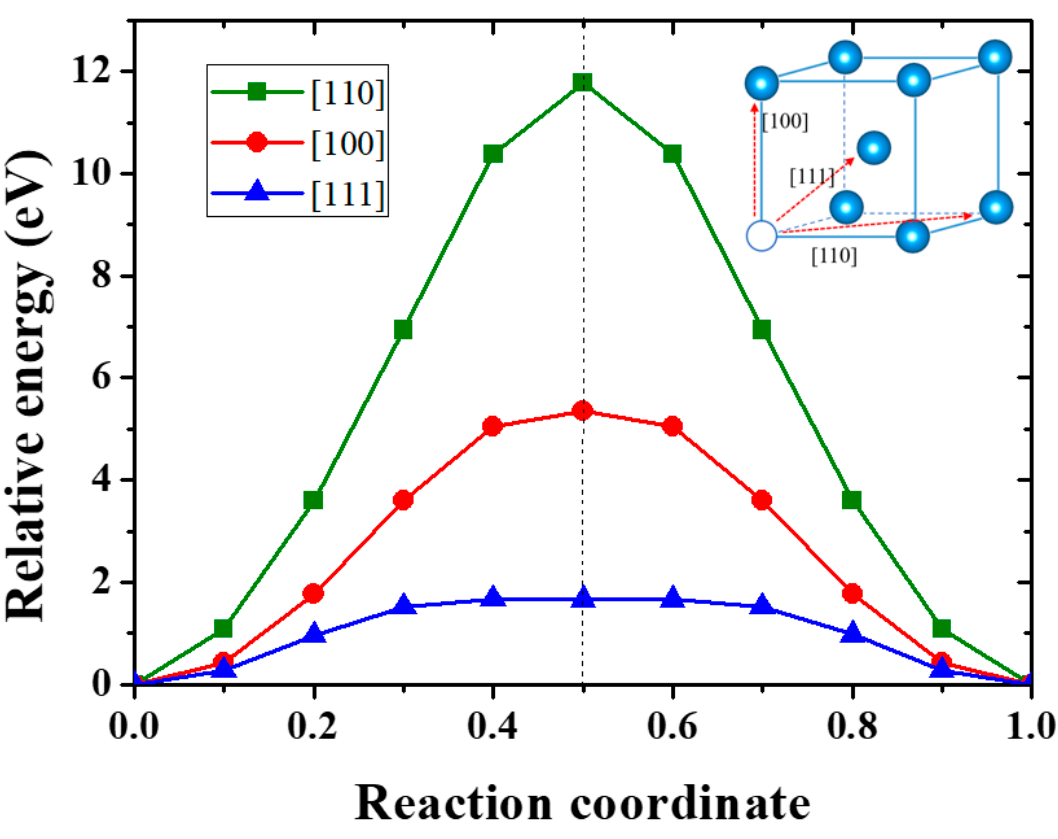
Figure 4. Energy profile for vacancy migration along the [111], [100], and [110] directions in unstrained W.